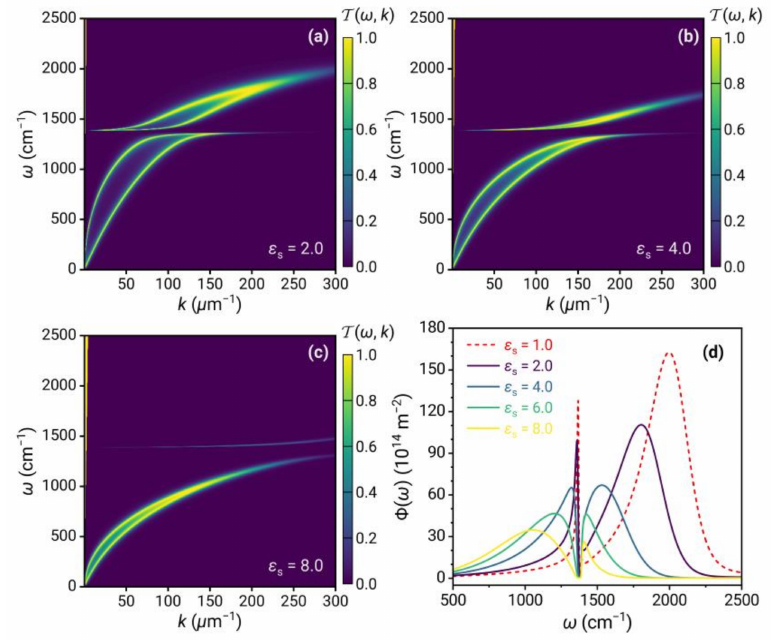
Figure 8. ( a – c ) Energy transmission coefficient T ( ω , k ; d ) and ( d ) energy transfer function Φ ( ω ) for 2D vdW heterostructures covered on the substrate with different ε s .